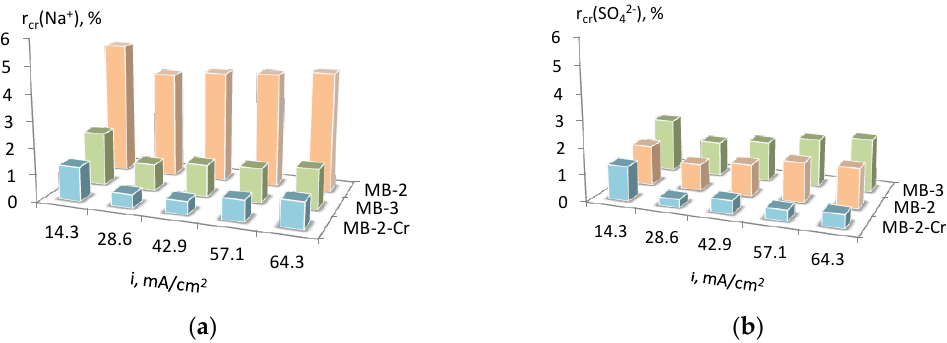
Figure 9. Degree of acid ( a ) and base ( b ) contamination with salt ions that crossed the membrane (determined using formula (12)).